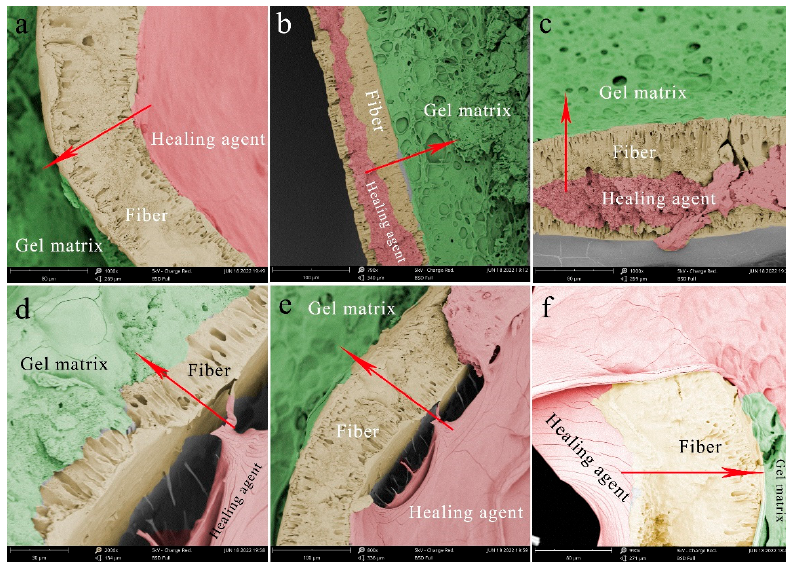
Figure 3. SEM morphology of interface morphology details between the gel matrix and fibers filled with a healing agent: ( a – c ) The healing agent penetrated the micro-porous structure. The red arrow indicates the direction of liquid penetration. ( d – f ) The whole process of liquid penetrating into the outer matrix of the fiber through micro-pores.